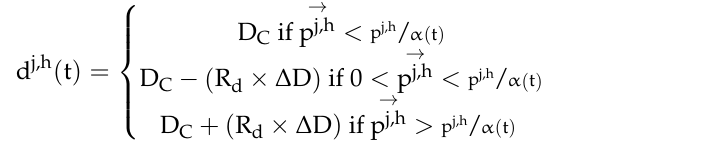
Figure 3. Flow of the ASO